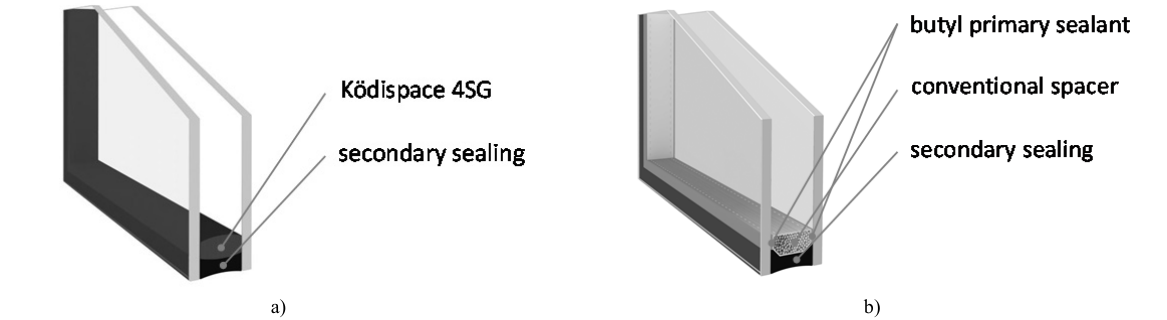
Fig. 1 Comparison IGU with a) Ködispace 4SG and b) aluminum spacer